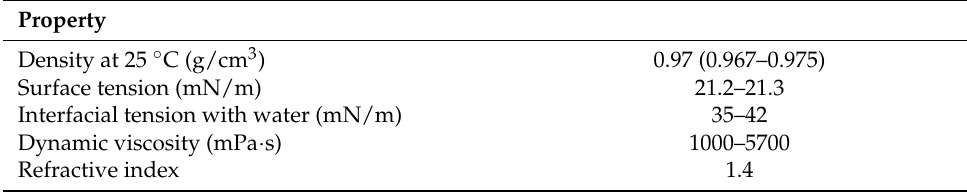
Table 1. Physical properties of silicone